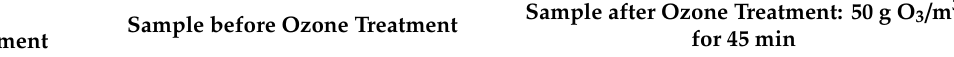
Table 1. Results of EDX (energy dispersive X-ray spectroscopy) analysis of Ti6Al4V titanium alloy sample before and after ozone